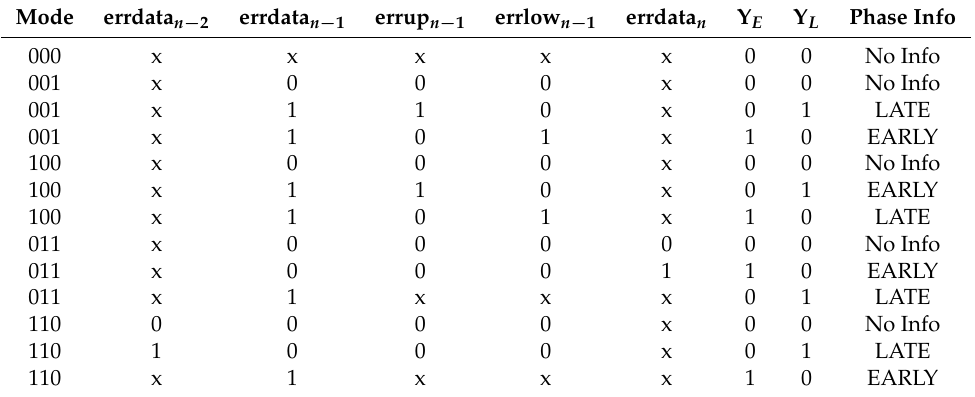
Table 4. MMPD phase-detection truth table for DB